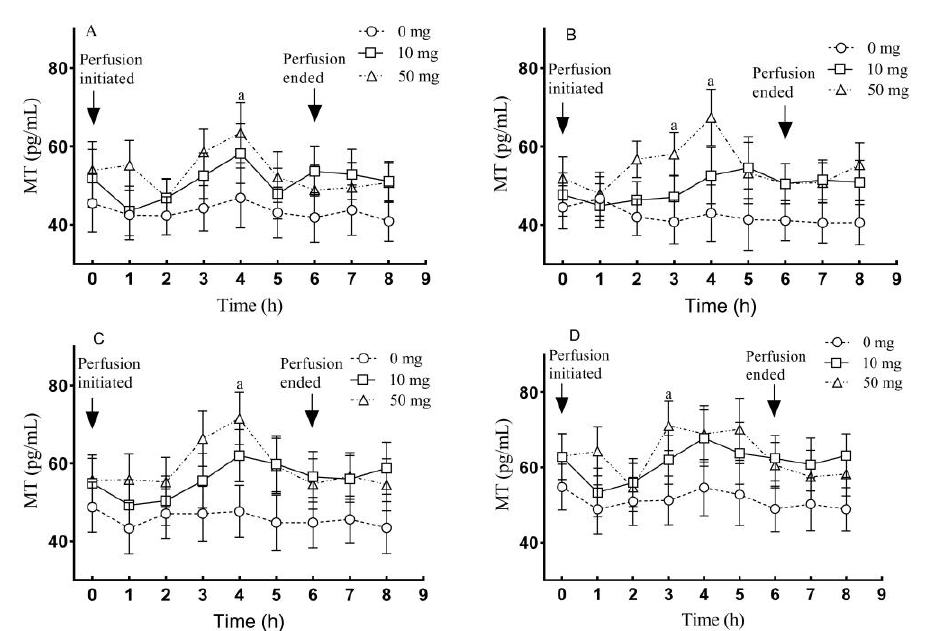
Figure 9. The timely dynamic changes of melatonin concentration in different blood vessels after 5-HTP duodenal perfusion. ( A ) Portal vein, ( B ) carotid artery, ( C ) jugular vein and ( D ) posterior vena cava. The data were expressed as LSM ± SEM ( n = 6). Small letters indicate p < 0.05 vs. their respective control